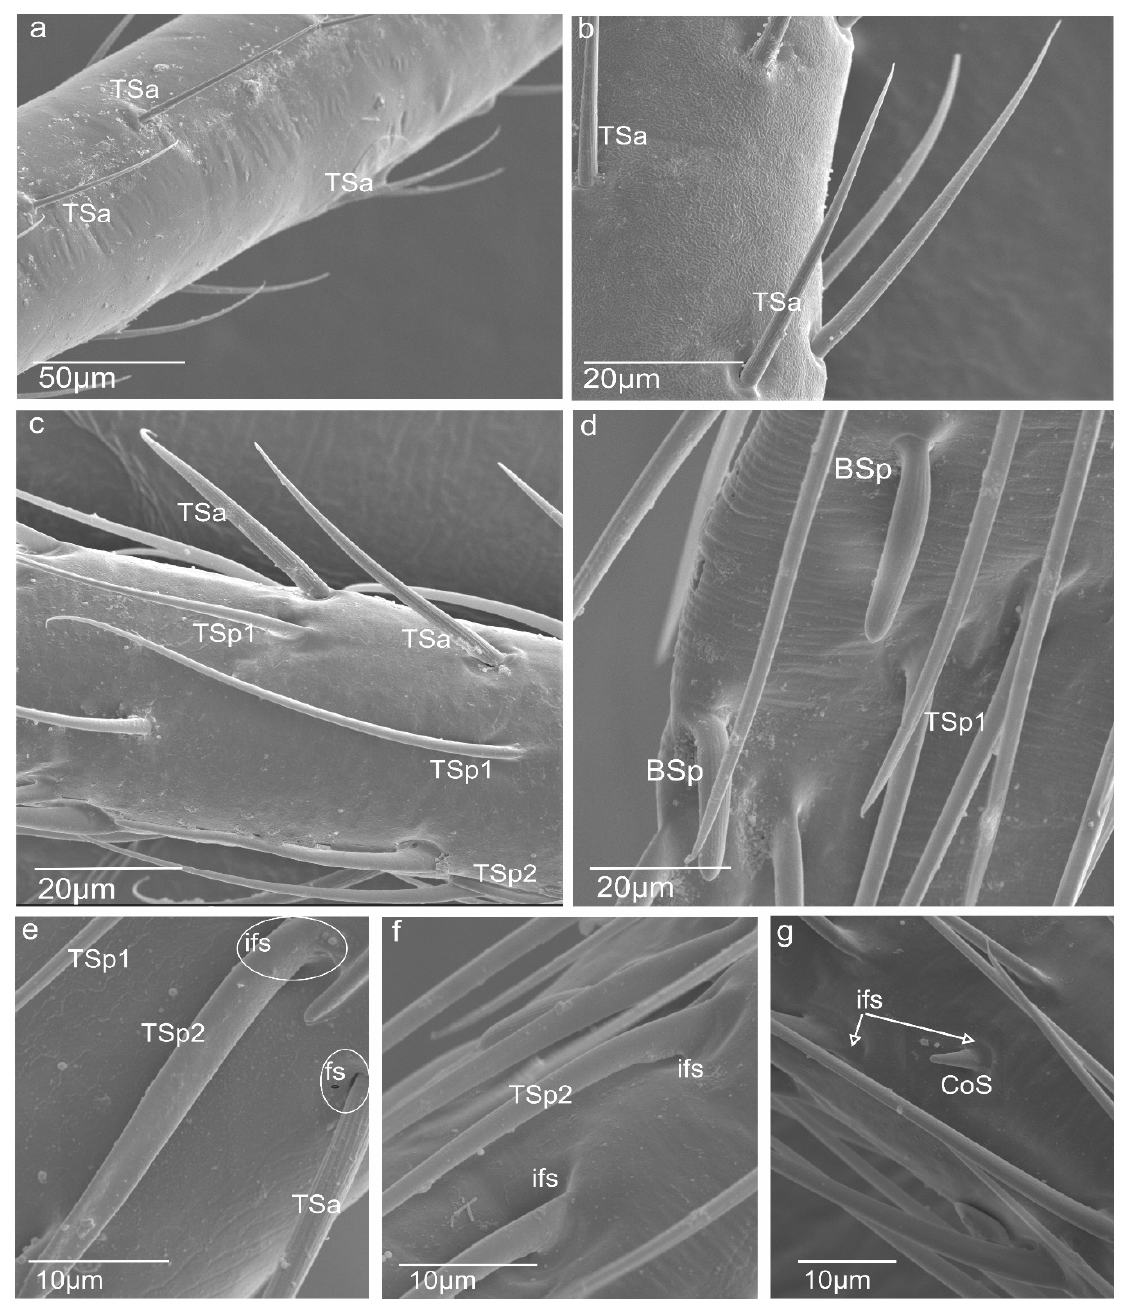
Figure 2. Photograph of N. rugosus antennae: ( a ) magnification of the scapus with trichoid sensilla (TSa); ( b ) magnification of the pedicel with trichoid sensilla (TSa) in the distal part; ( c ) magnification of the trichoid sensilla (TSa) and trichoid sensilla (TSp1, TSp2) on the first flagellum; ( d ) magnification of the trichoid sensilla (BSp, TSp1) on the second flagellum; ( e ) magnification of the porous surface of the trichoid sensilla and groove surface of the trichoid a porous sensilla (TSa) with the flexible socket (fs); ( f ) inflexible socket of sensillum (ifs); ( g ) coeloconic sensillum (CoS) observed on two flagellomeres.